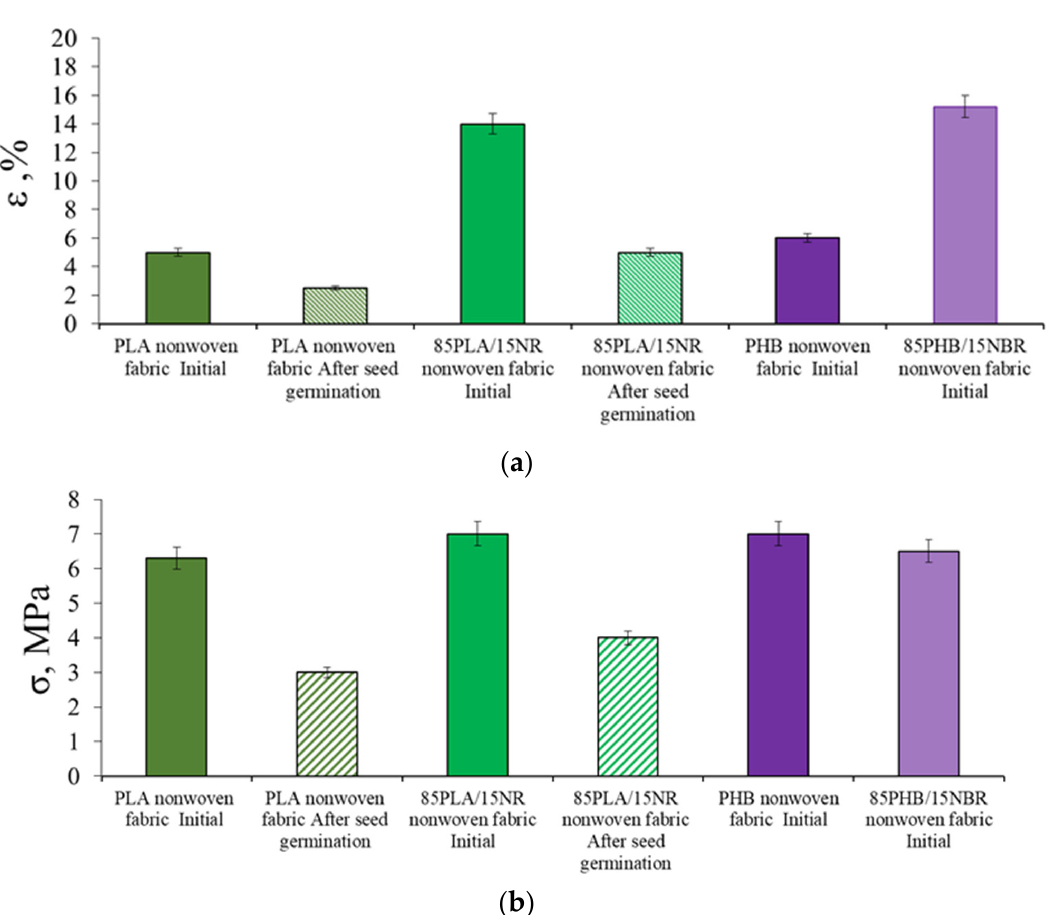
Figure 9. The change in the elongation at break ( a ) and tensile strength ( b ) of PLA, PLA/NR and PHB, PHB/NBR nonwoven fabrics.